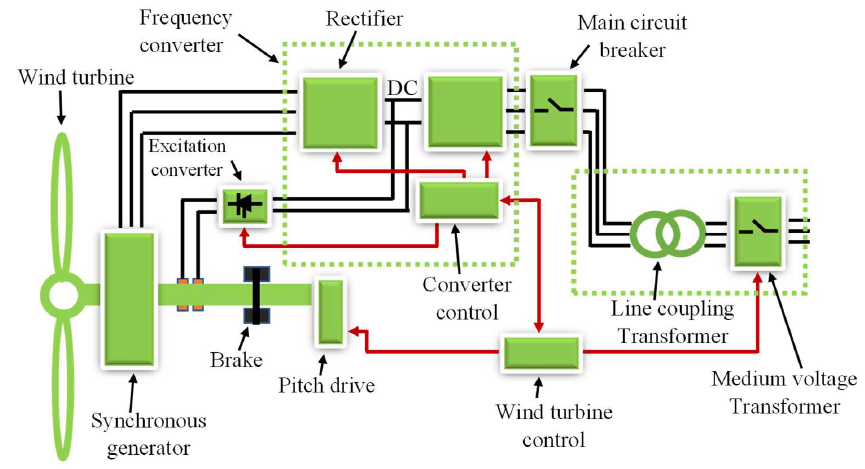
Figure 6. EESG with full-scale power converter [46].